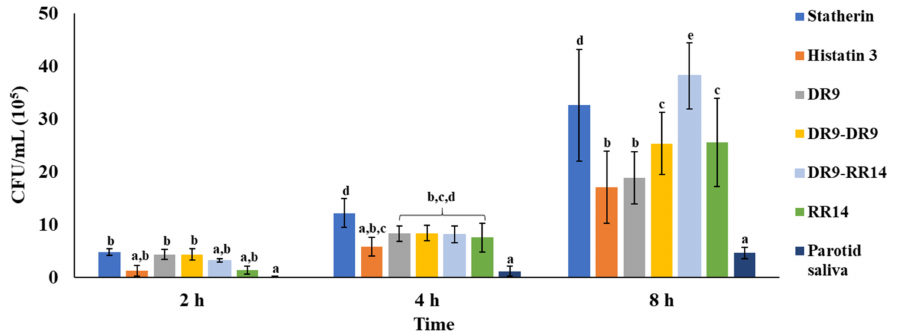
Figure 3. Colony-forming units (CFU/disc*10 5 ) of S. mutans adhered to hydroxyapatite (HAp) discs at each time point according to the treatments. Distinct lower-case letters show significant differences among treatment groups at the same time point (2 h, 4 h, and 8 h) (ANOVA and Bonferroni test, p < 0.05) (Mean ± SD; n =